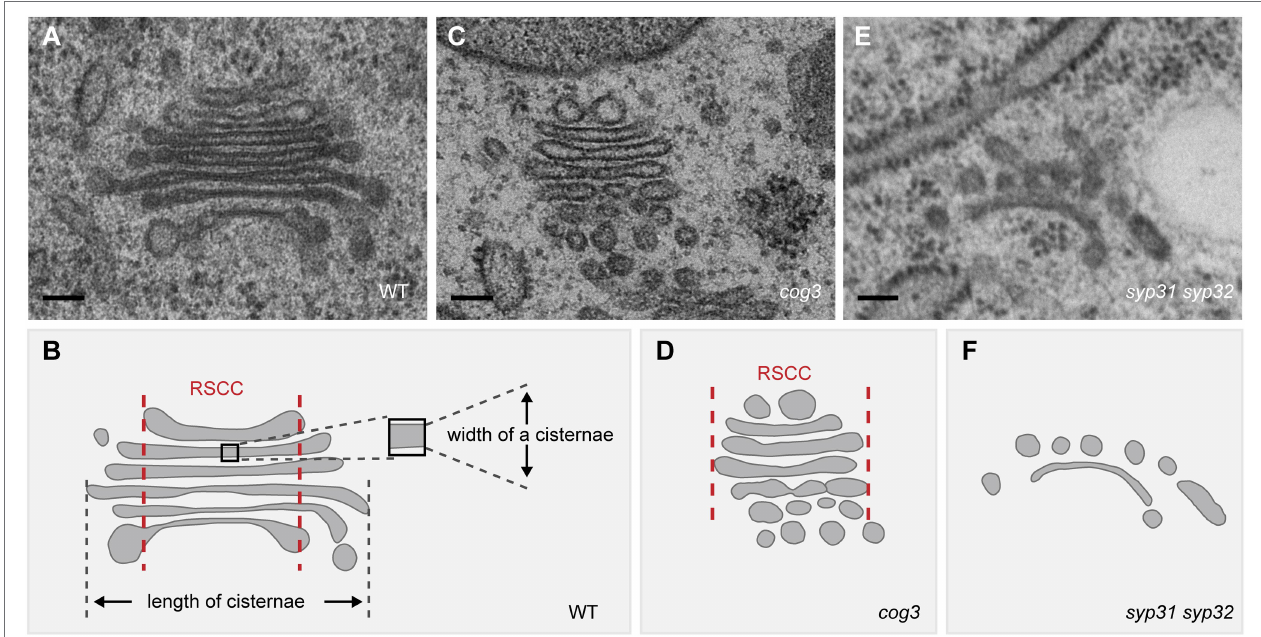
FIGURE 2 | Disruption of the Golgi structure in cog3 and syp31 syp32 mutant pollen based on the TEM observation. (A,C,E) Representative TEM images of the Golgi in WT (A) , cog3 (C) , and syp31 syp32 (E) pollen. (B,D,F) Diagram of the Golgi structure in WT and mutants. Relative stable cisternal center (RSCC) is indicated between a pair of red lines in (B) and (D) . Bars = 100